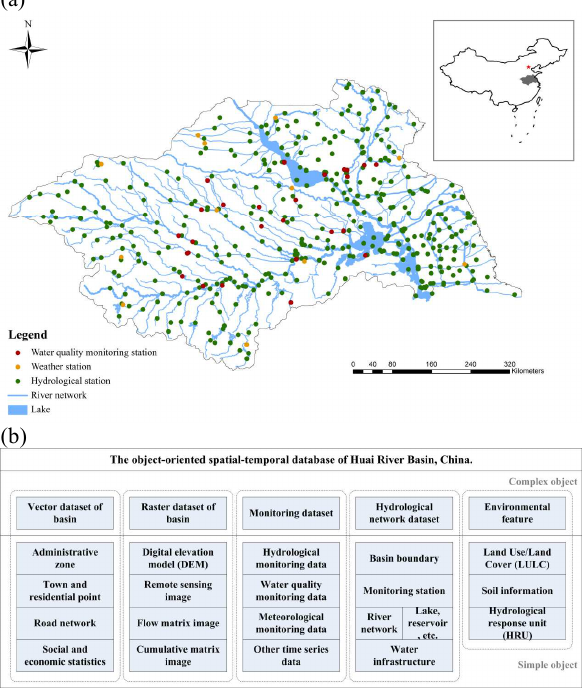
Figure 1. (a). Map of Huaihe Basin, China. (b). The object- oriented spatio-temporal